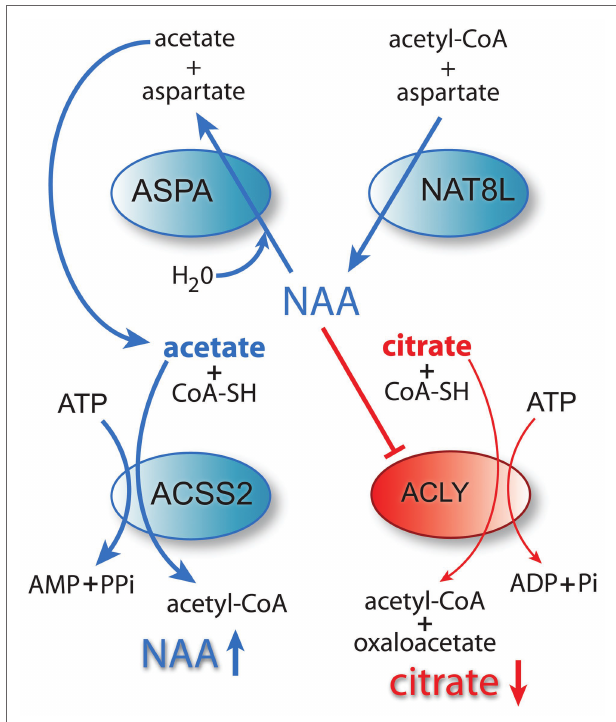
FIGURE 5 | The NAA and citrate pathways to acetyl-CoA. The NAA-ASPA- ACSS2 pathway to acetyl-CoA formation is shown in blue, whereas the citrate lyase pathway is shown in red. High NAA levels inhibit ACLY activity in brown adipose tissue, and this may turn out to be a more general phenomenon in other cell types including oligodendrocytes and certain types of cancer cells. This would shift mitochondrial output of the tricarboxylic acid cycle from citrate to NAA, which would in turn activate the ACSS2 pathway to acetyl-CoA formation. When this pathway is activated in the cell nucleus, it can affect the activity of select transcription factors and modulate transcriptional